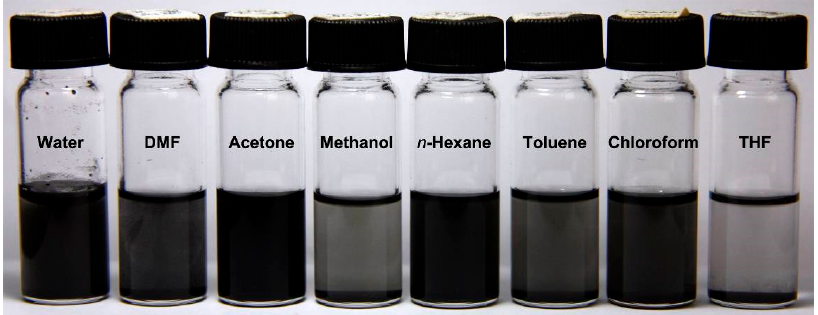
Figure 2. Digital photo of GO-PFcMAss in different organic solvents and water.